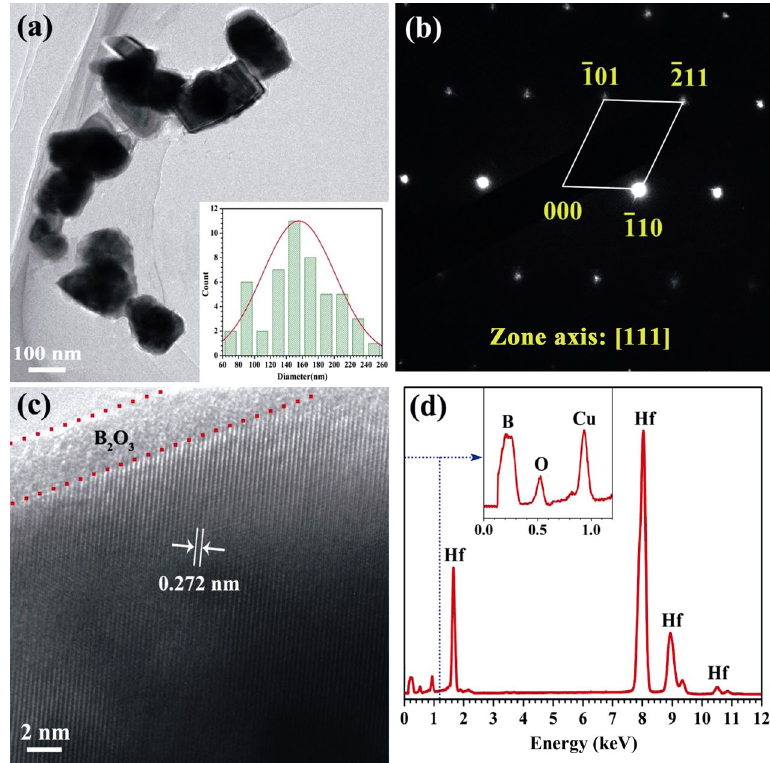
Fig. 3 TEM analysis of HfB 2 products synthesized at 1373 K with molten salts: (a) TEM image, (b) SAED pattern, (c) HRTEM image, and (d) EDS spectrum.